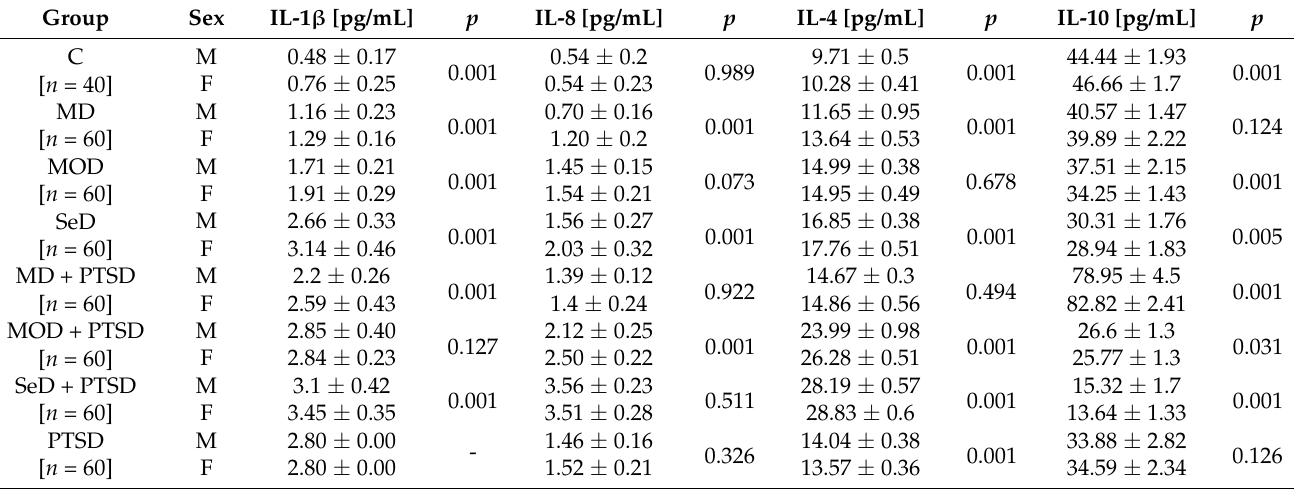
Table 1. Comparison of IL-1 β , IL-8, IL-4, IL-10 between males and